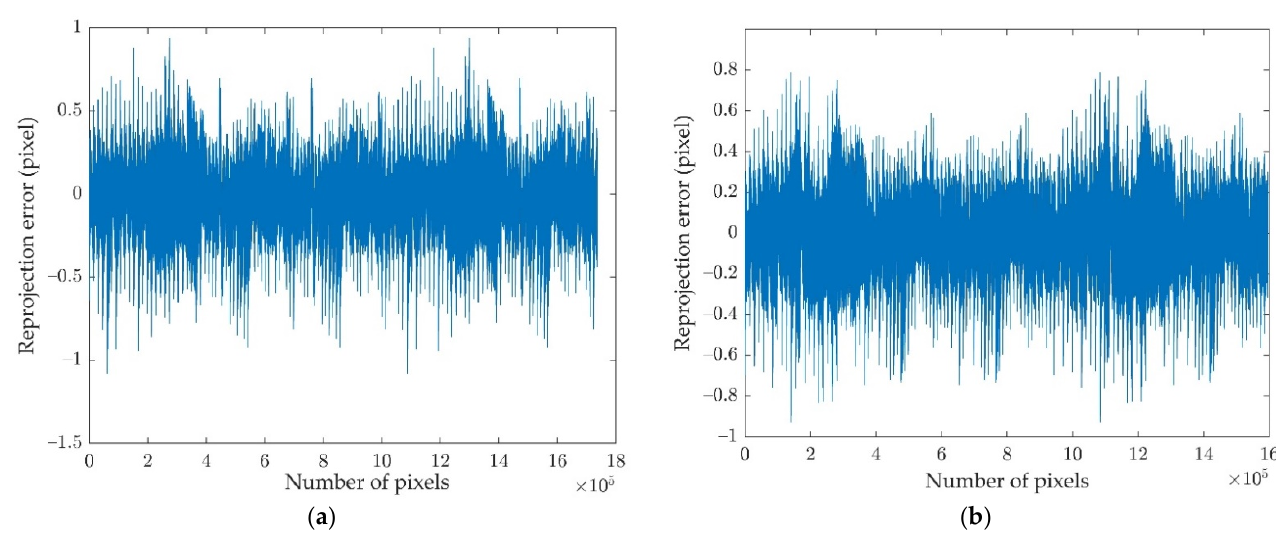
Table 1. The normal vector of LCD screens (units: ° ).